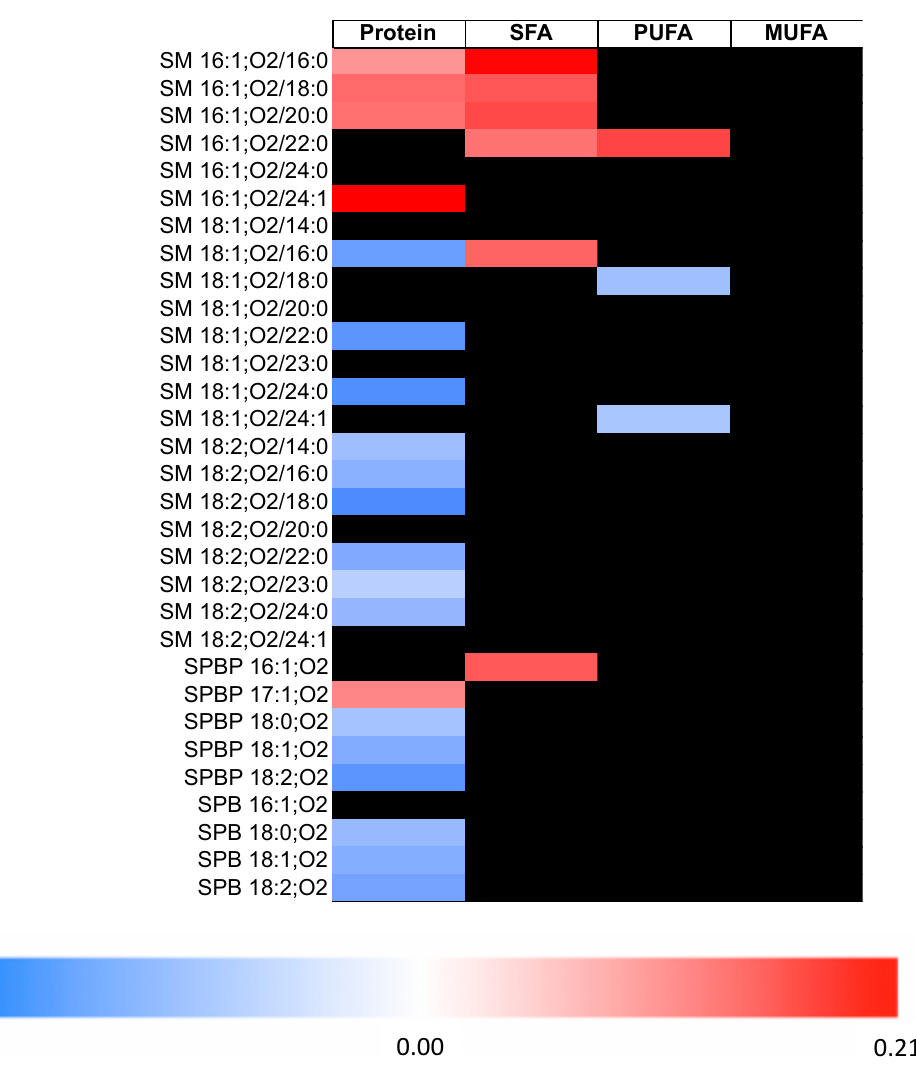
Figure 1. Associations between intakes of protein and different types of fat, and individual sphingolipid concentrations of the SP2 participants ( n = 2860). Associations that are not statistically significant (adjusted p > 0.050) after Benjamini-Hochberg correction are indicated with a black box. We quantified 26 ceramides (Cers), 16 monohexosylceramides (HexCers), 6 dihexosylceramides (Hex2Cers), 22 sphingomyelins (SMs), 5 sphingoid base phosphates (SPBPs), and 4 sphingoid bases (SPBs) for a total of 79 sphingolipid species. The colors are beta coefficients from linear regression analysis representing the change per SD in circulating sphingolipids (log-transformed values) for every 5% of total energy intake increment in nutrient intake. We adjusted for age, sex, energy intake, BMI, alcohol intake, physical activity, cigarette smoking, high-density lipoprotein cholesterol, low-density lipoprotein cholesterol, and triglycerides. Additionally, for protein and total fat outcomes, we mutually adjusted them for each other, and for saturated fat, polyunsaturated fat, and monounsaturated fat outcomes, these were mutually adjusted for each other in addition to protein intake. Abbreviations: MUFA, monounsaturated fatty acid, PUFA, polyunsaturated fatty acid, SFA, saturated fatty acid.